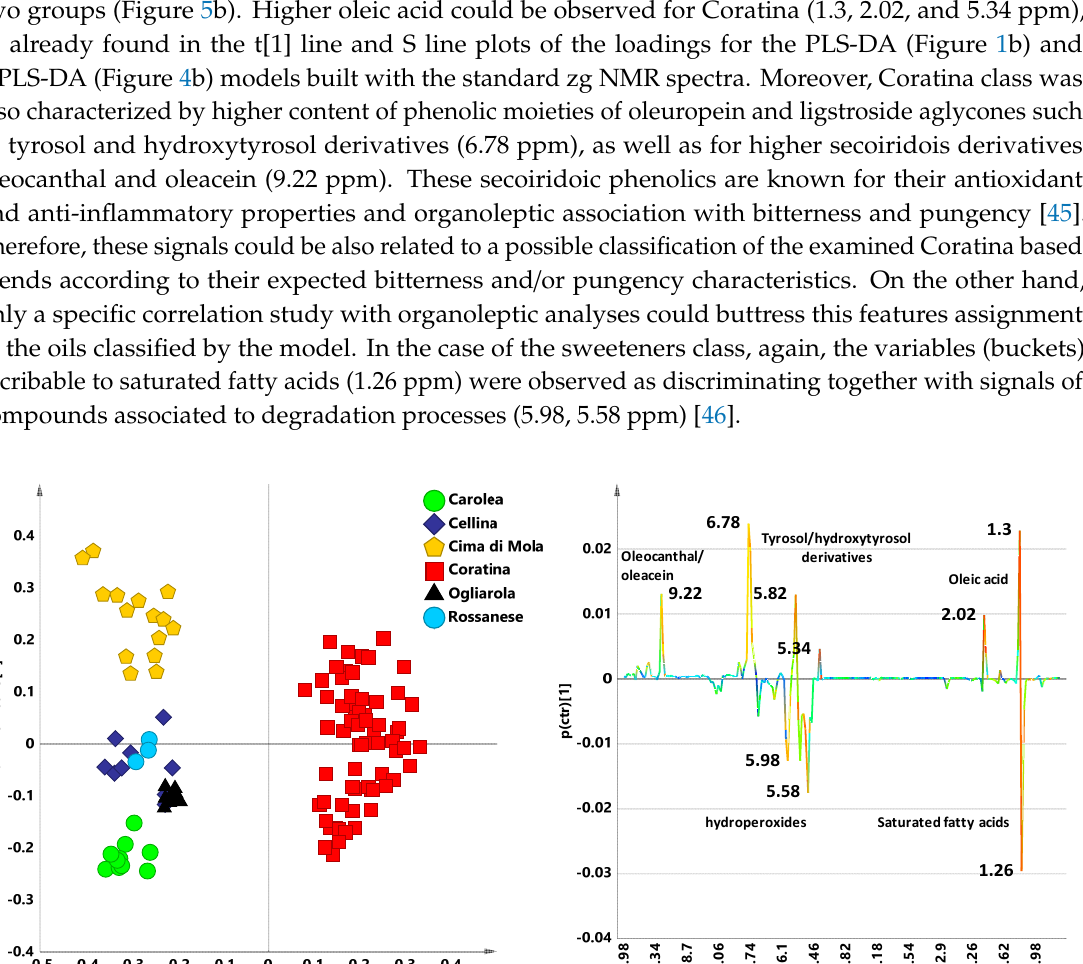
Table 3. Misclassification table summarizing the classified observations in the OPLS-DA models built with bucket reduced zg and zg-noesy NMR spectra.